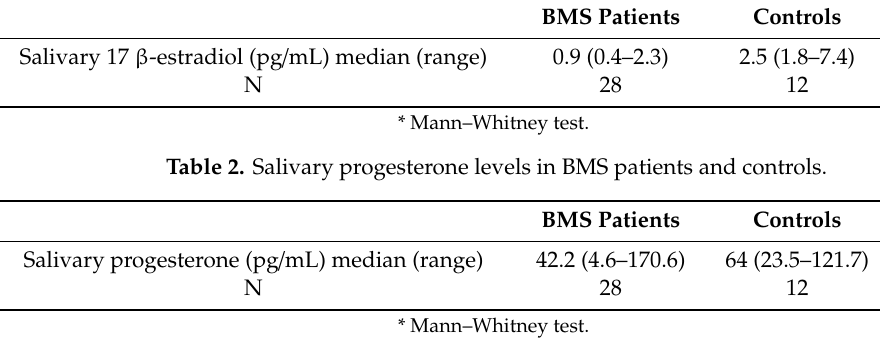
Table 3. Salivary dehydroepiandrosterone (DHEA) levels in BMS patients and